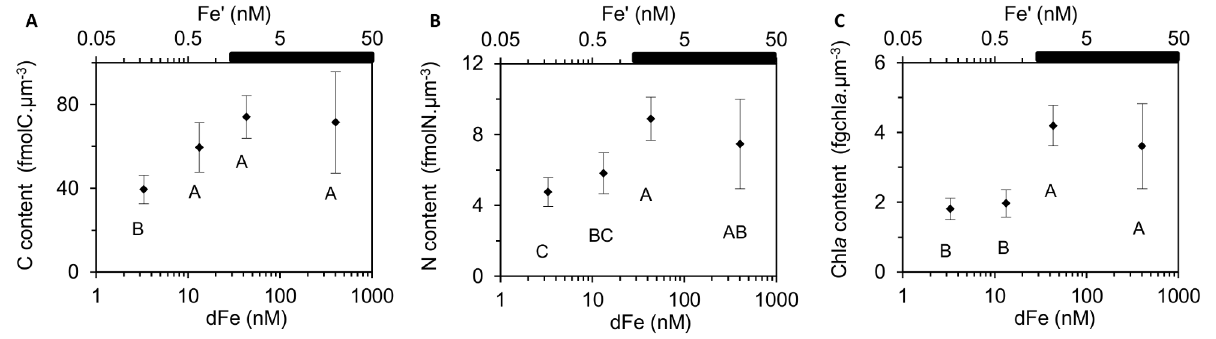
Figure 4. Influence of Fe availability on V-normalized contents. Mean V-normalized contents of C (A), N (B) and Chl a (C) of C. watsonii related to dFe and Fe 9 concentrations, in log scale. Error bars represent standard deviation; different letters correspond to statistically different means ( p , 0.05) and the black bar indicates the region of expected Fe hydroxide precipitation.